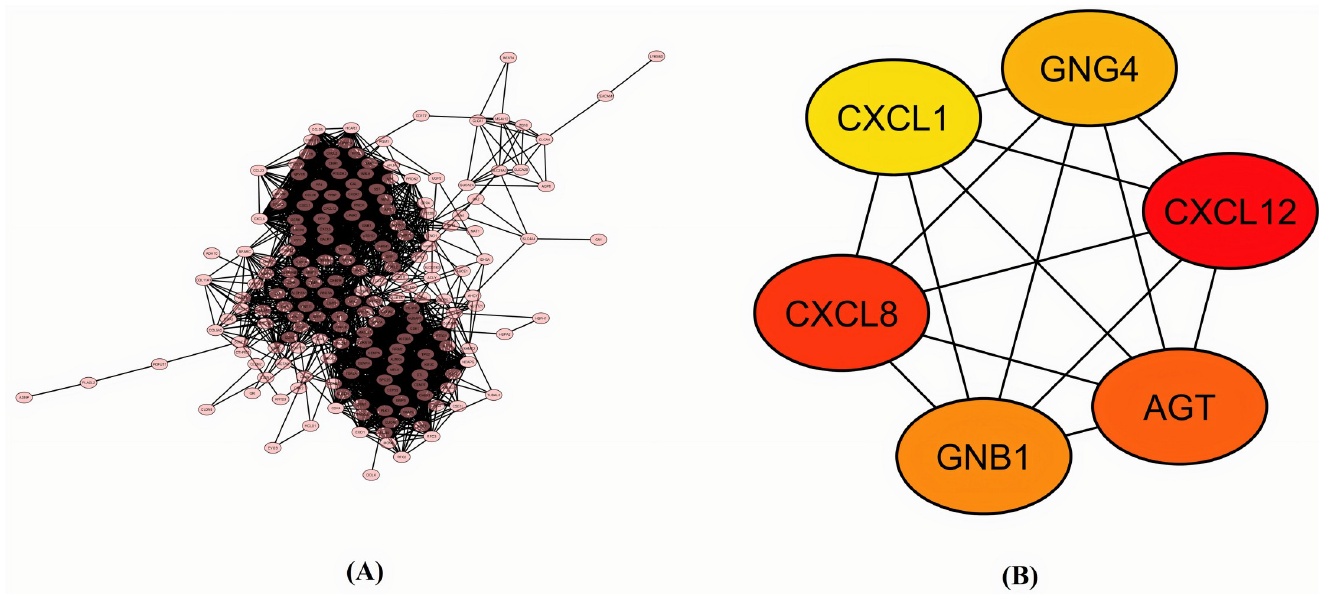
Fig 2. (A) A PPI network of all the 210 extracted hub genes. (B) A network of six real hub genes identified on the basis of degree of centrality.